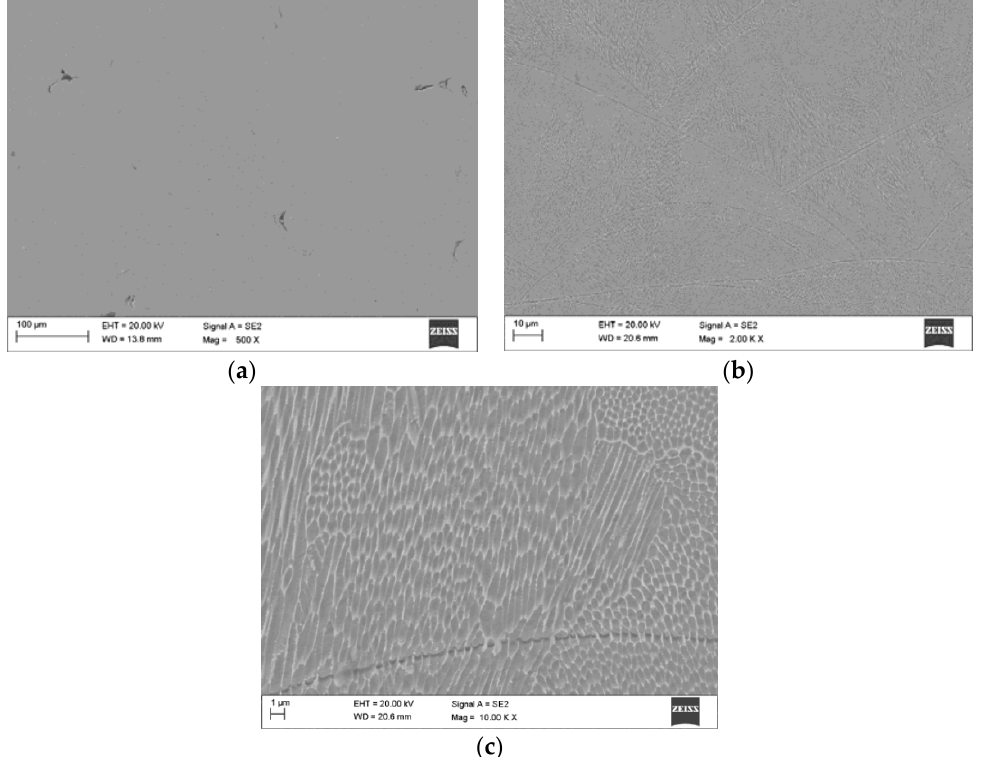
Figure 8. Microstructure of the as ‐ built SLM Ni ‐ 18 (M300) steel during optimum process conditions (sample No. 4): ( a ) cross ‐ sectioned scanning electron microscope (SEM) image with visible porosity, ( b ) SEM image after etching, and ( c ) the cellular structure of analyzed steel at high ‐ magnification.